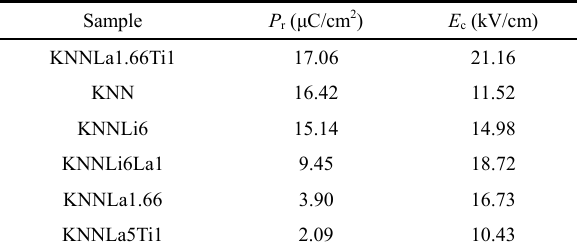
Table 3 Remnant polarization and the coercive electric field of the analyzed